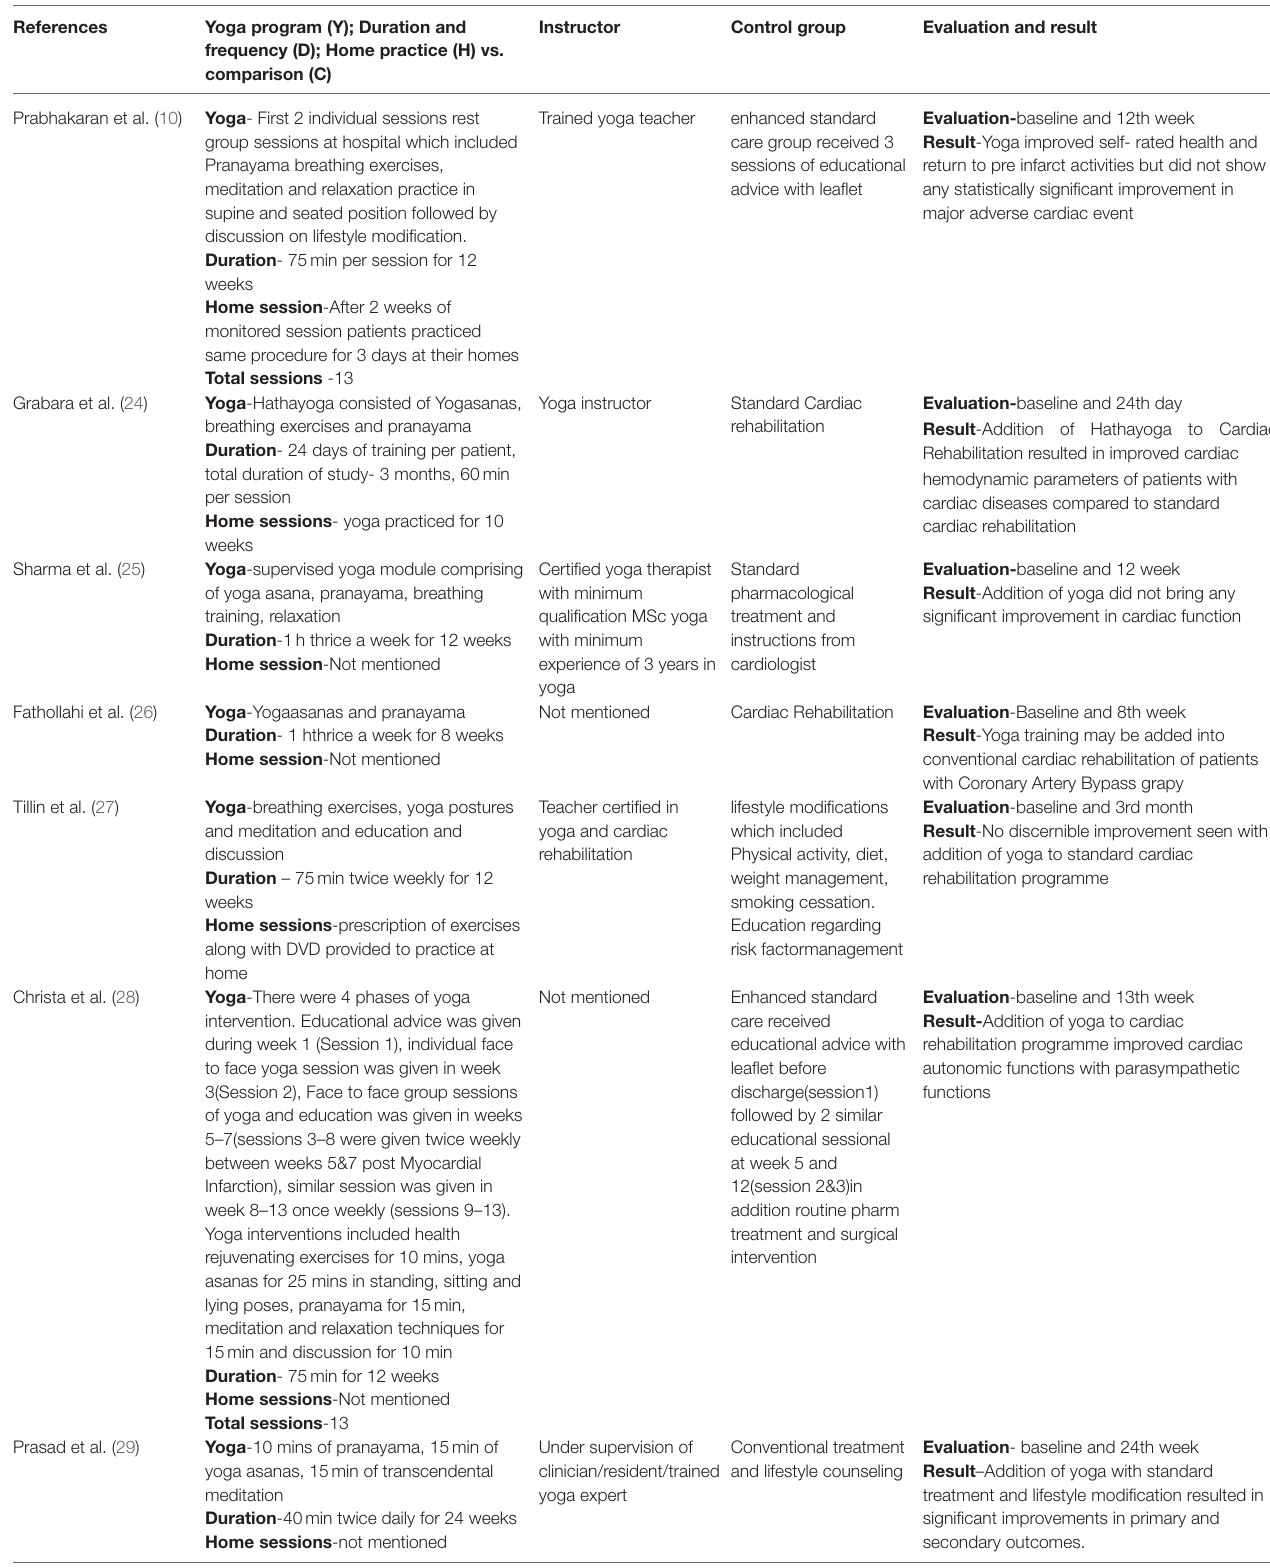
TABLE 2 | Description of yoga program and attendance to